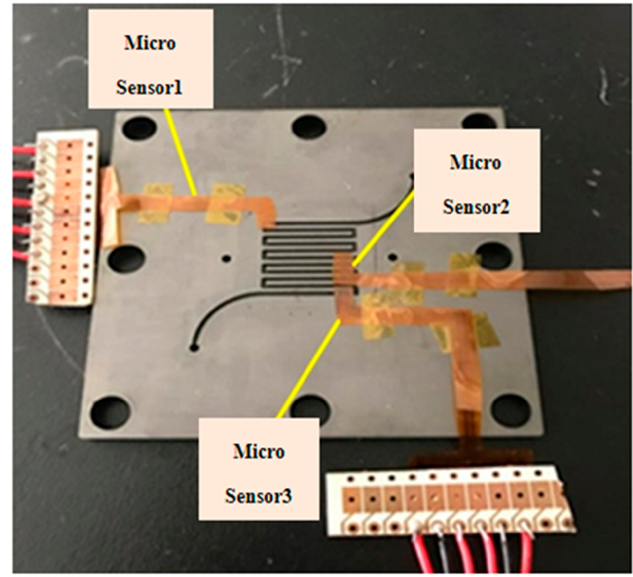
Figure 4. Schematic diagram of flexible integrated microsensor embedded in the cathode channel plate.